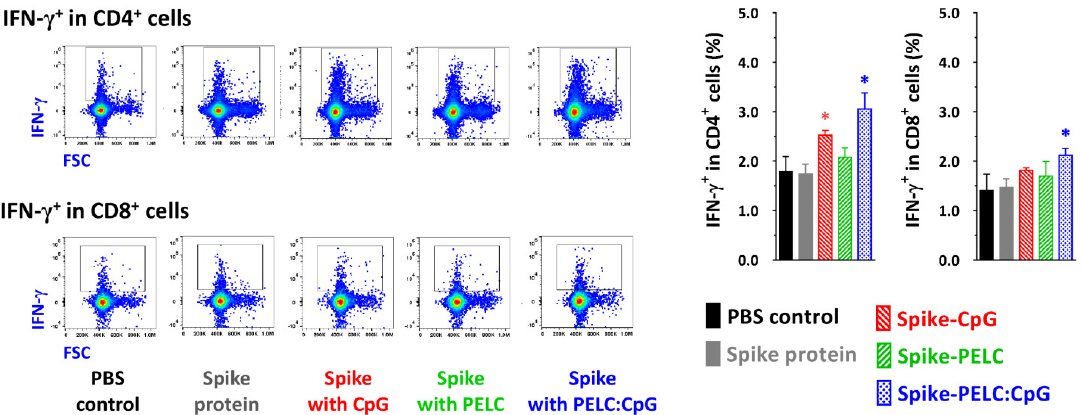
Figure 6. Cytokine secretion response following intranasal vaccination with PELC:CpG-formulated S protein. BALB/c mice were given three intranasal doses of SARS-CoV-2 S protein antigen. Two weeks after the final vaccination, splenocytes (5 × 10 6 cells/mL) were harvested and then incubated in the presence of S protein (5 µ g/mL). Supernatants collected from cell cultures were assessed by IFN- γ , IL-2, IL-5, IL-10, and IL-13 ELISA. The data are presented as cytokine release in the presence of S protein minus those released in the absence of S protein and expressed as the mean ± standard deviation of triplicate cultures of pooled spleen samples. * p < 0.05 in comparison with nonadjuvanted S protein group.